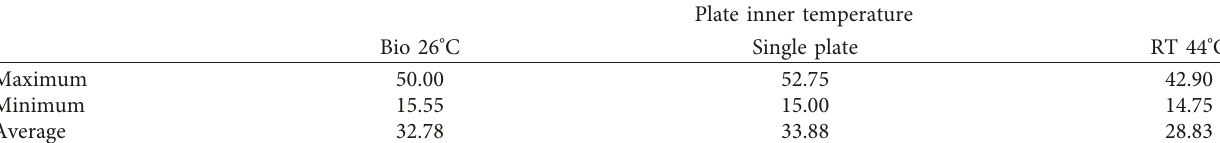
Table 5: Plate inner temperature measurements of Test 1 ( ° C).